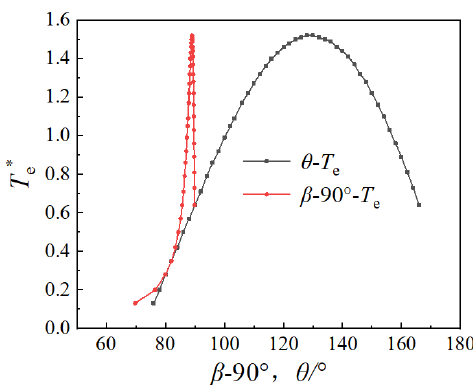
Figure 13. The curve of per unit value of torque at λ = 0.3.